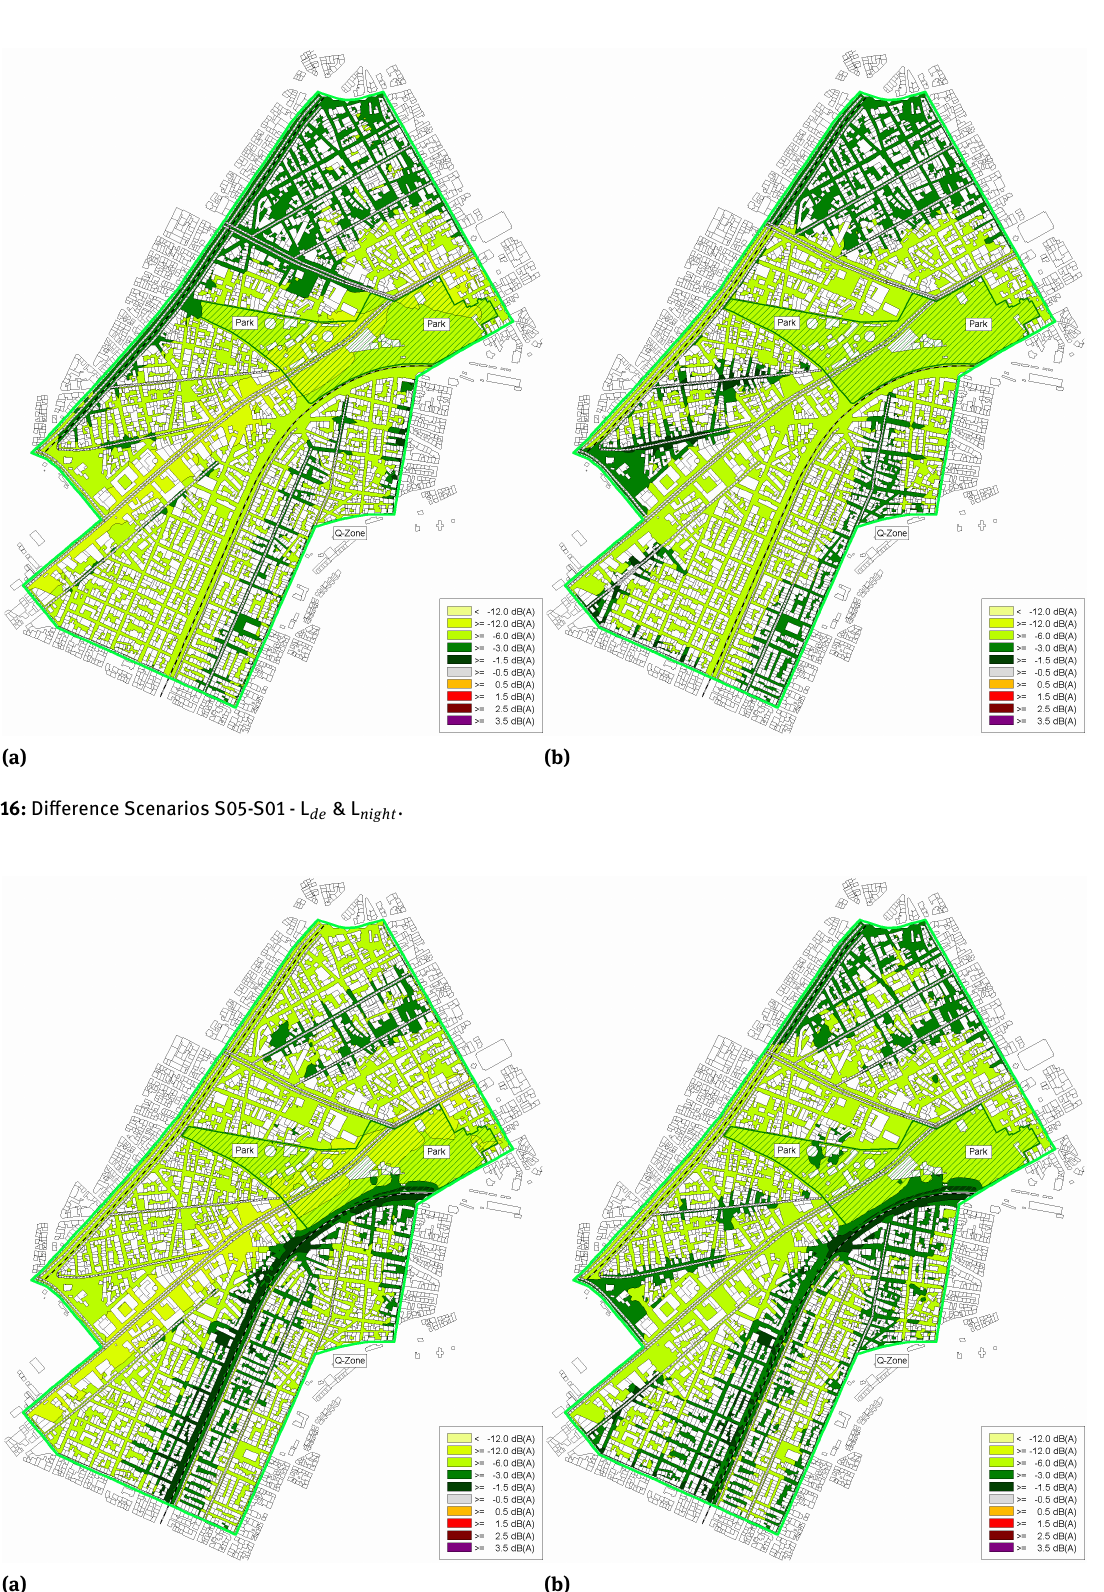
Figure 17: Difference Scenarios S06-S01 - L